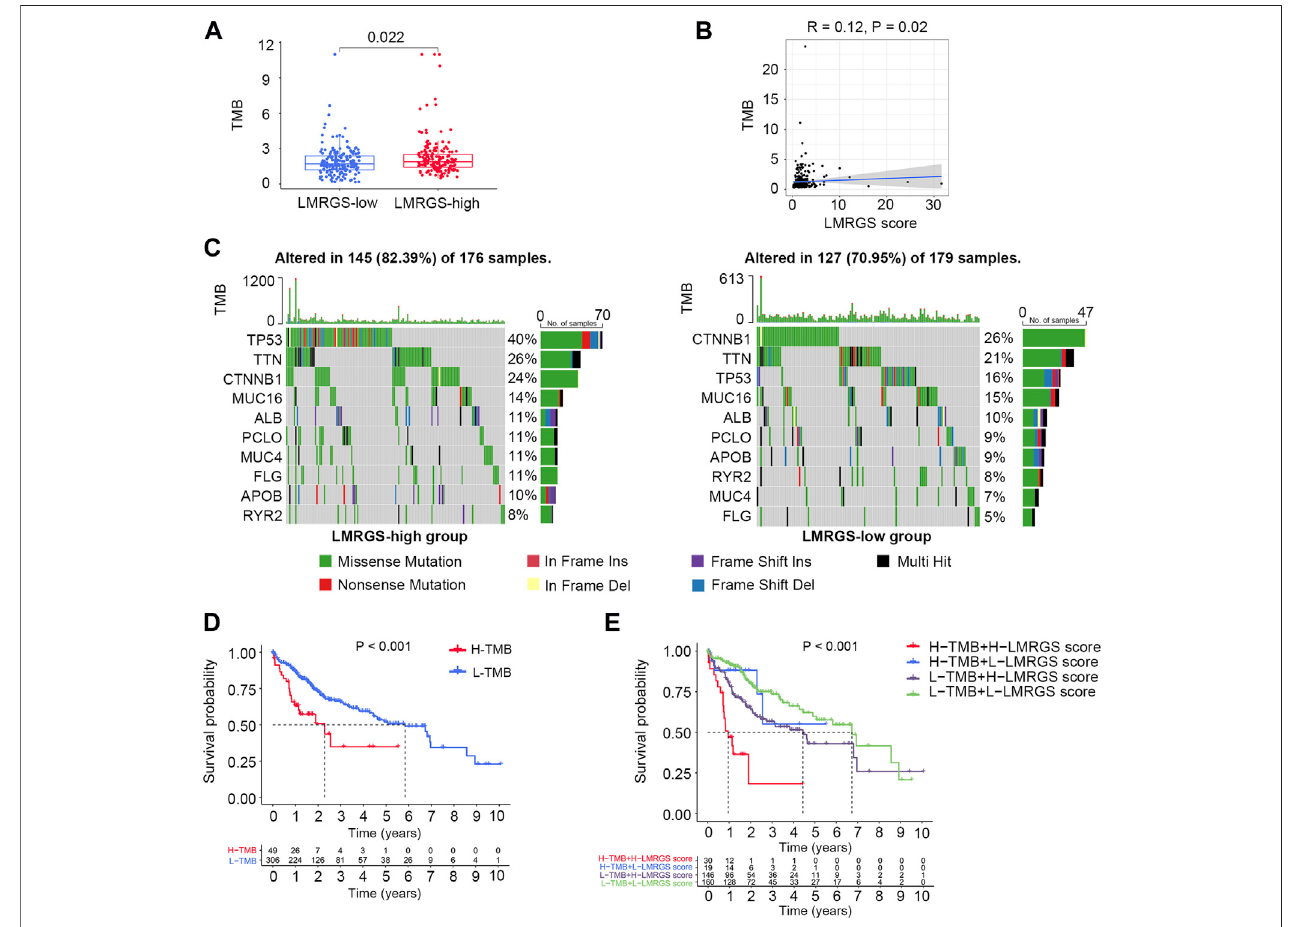
FIGURE 6 | Tumor mutation characteristics in different LMRGS subgroups. (A) The differences of TMB in LMRGS-low and LMRGS-high groups. (B) The association of TMB with LMRGS score. (C) Top 10 mutated genes in different LMRGS subgroups. (D) KM survival analysis of TMB. (E) Effects of the LMRGS score combined with TMB on the overall